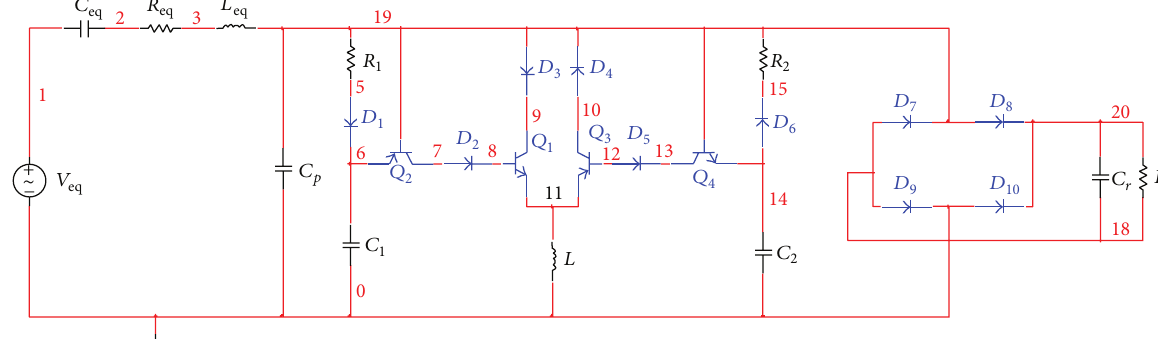
Figure 6: The first-class system-level coupled model of the PVEH